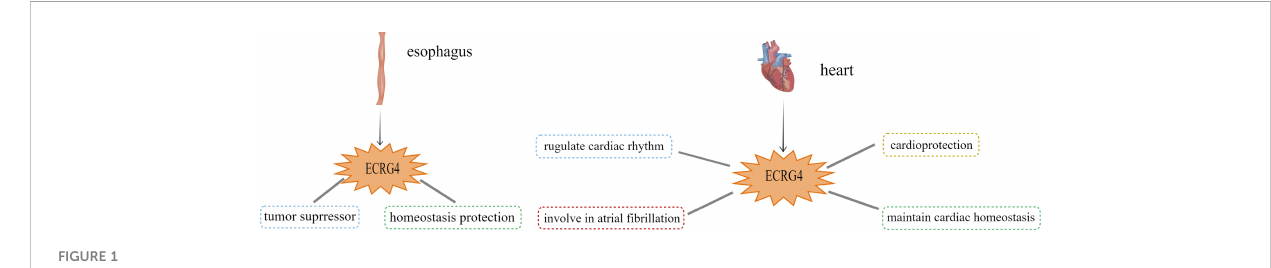
FIGURE 1 Potential functions of ECRG4 in the esophagus and cardiovascular